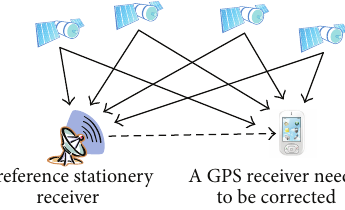
Figure 1: An illustration of dGPS scenario. The precise location of the reference stationary receiver is known. A GPS receiver which requires correction accepts both signals from satellites and the stationary receiver.